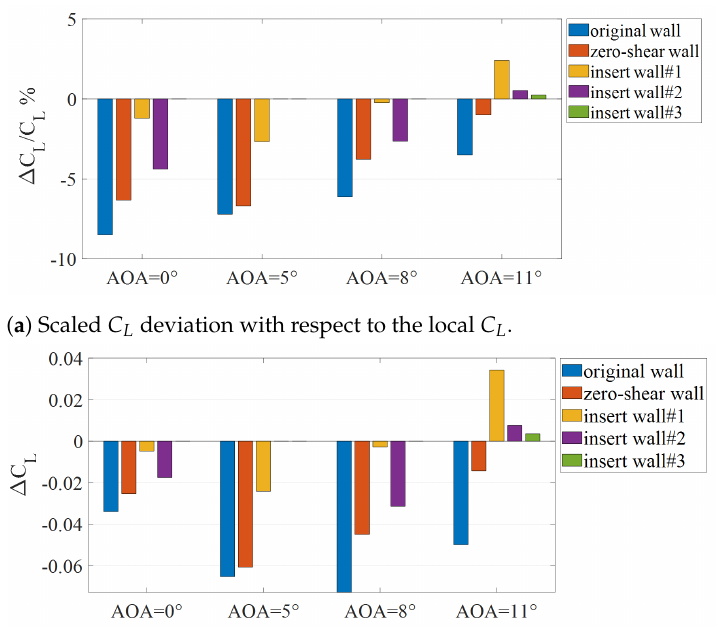
Figure 13. Relative deviation between the lift in free-flight conditions and that in the wind tunnel, using various insert designs. The insert wall numbers are according to Table 2 and the number of bars may differ for different